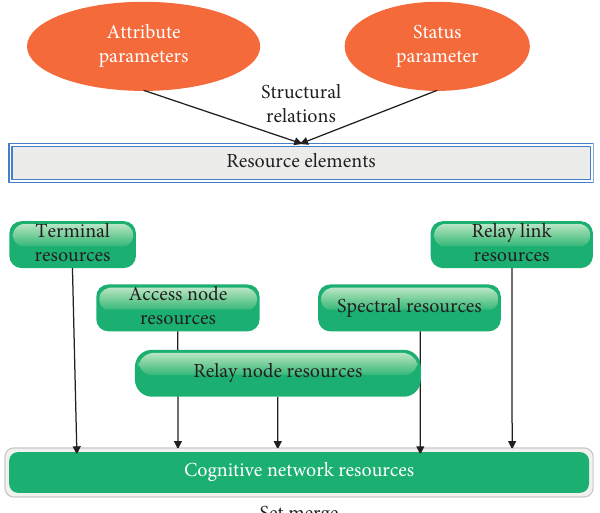
Figure 3: The relationship and analysis structure of project cost data, project cost data elements, and characteristic